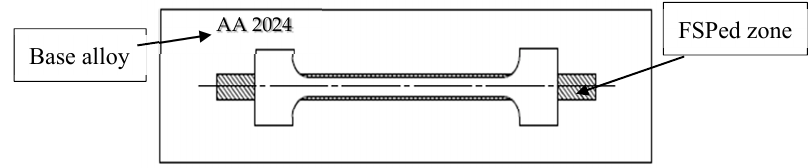
Figure 2. Schematic drawing of the tension specimen and direction of cutting. Materials 2017 , 10 , 1053